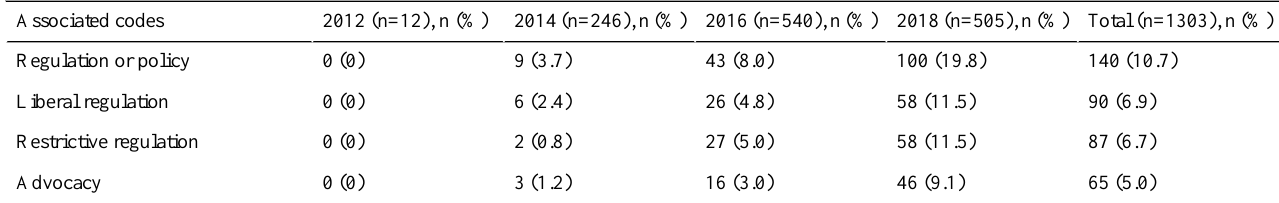
Table 7. Frequency statistics for each year corpus and the total sample within the “regulation and advocacy” domain.